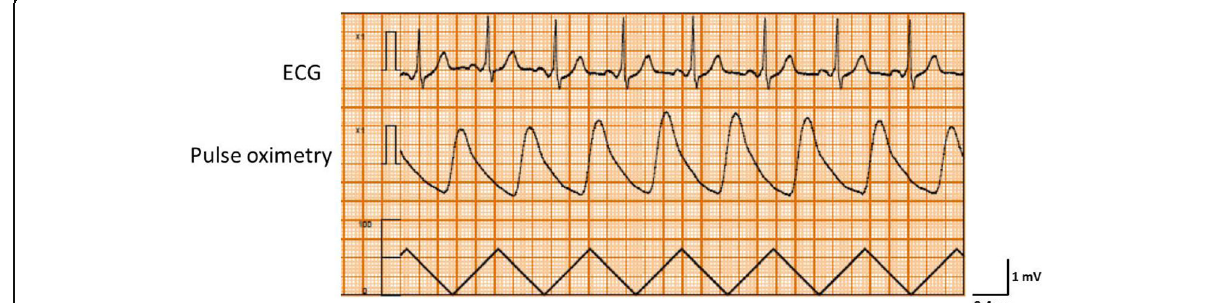
Fig. 2 Intraoperative monitor (ECG, pulse oximetry, ABP) after surgery was started. The ECG monitor showed sudden premature ventricular contractions (PVCs) with wide QRS complexes and ventricular